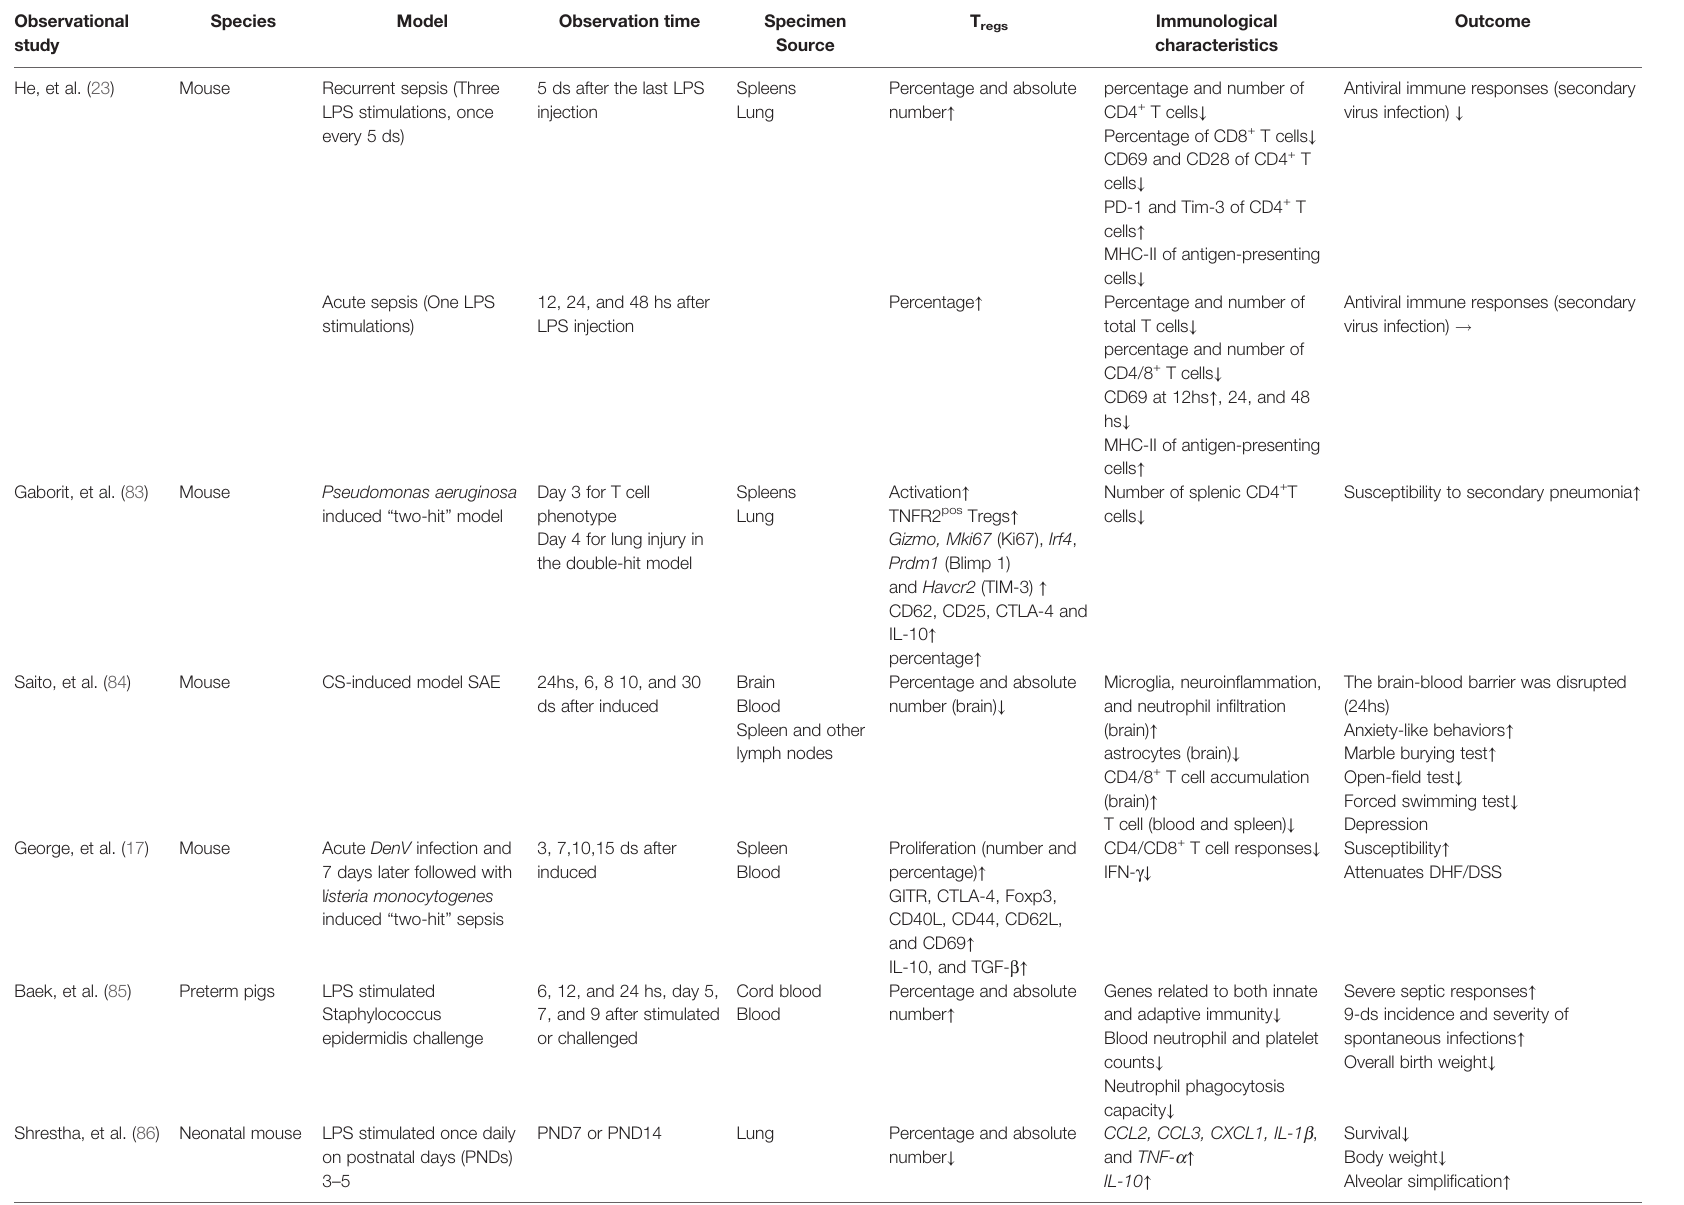
TABLE 1 | Observational studies using animal models focused on the characteristics of T regs in